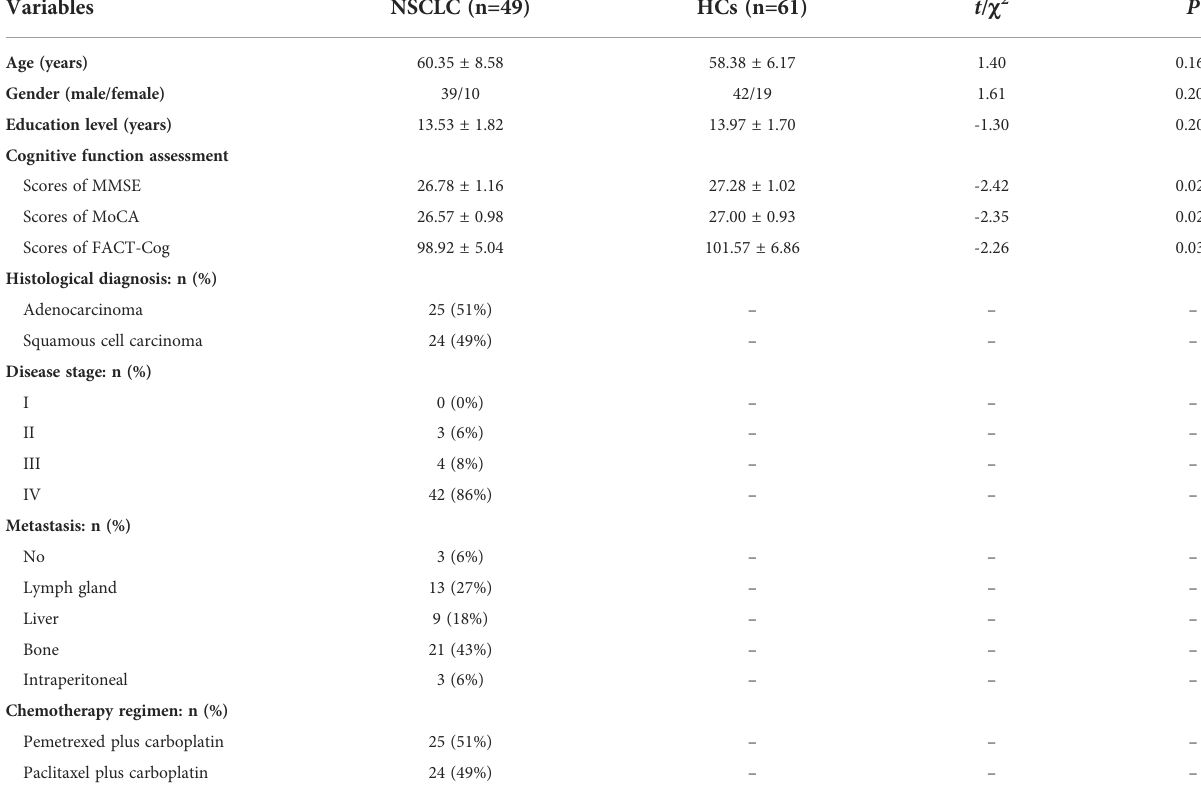
TABLE 1 Demographic and clinical characteristics of NSCLC patients and